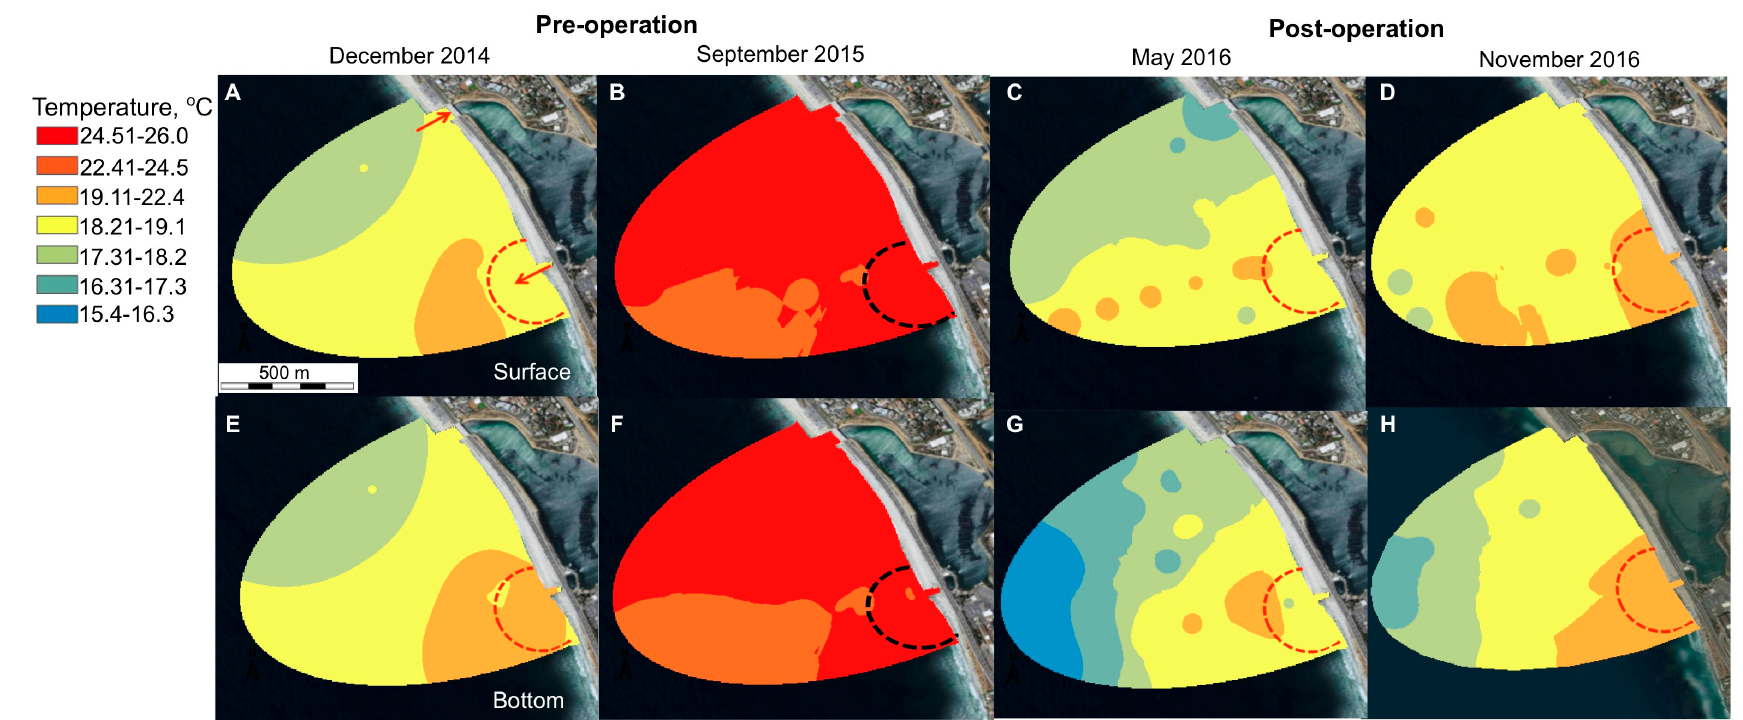
Figure 3. GIS-mapped temperature measurements for surface ( upper row ) and bottom water ( lower row ) for pre-operation ( A , B , E , F ) and post-operation ( C , D , G , H ). Arrows in ( A ) indicate locations of the outfall and lagoon intake. September 2015 was an El Niño year with higher average temperatures in the coastal zone ( B , F ). The red semi-circle (black for Sep 2015) represents the 200 m distance set by the California Ocean Plan (2015 Amendment to Water Quality Control Plan).